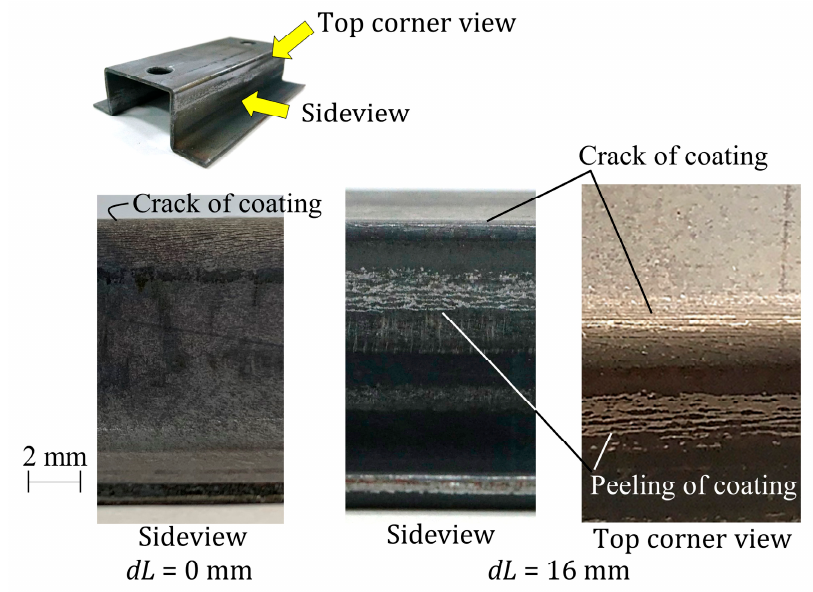
Figure 19. Surface appearances of hot-hat bent parts for d L = 0 mm and 10 mm.